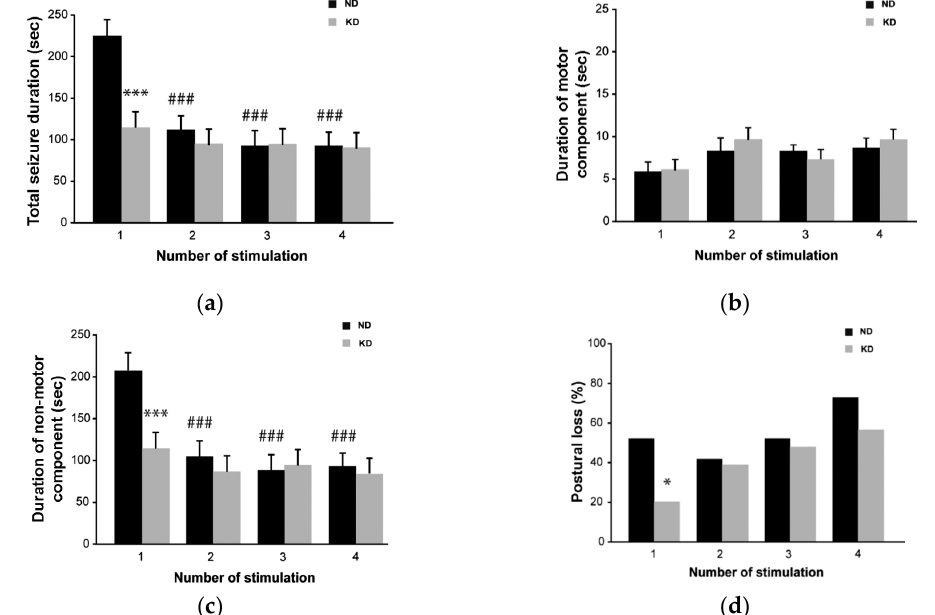
Figure 1. Behavioral changes during repeated 6-Hz corneal stimulation in mice fed the ketogenic diet (KD). ( a ) Seizure duration, considered as the overall period including both motor (convulsions) and non-motor (stunned posture) components of the seizure, was significantly shorter in KD vs. control mice at the first session (*** p < 0.001; Holm–Šídák test); however, after the first session the seizure duration decreased in control mice (### p < 0.001 for sessions 2, 3 and 4 vs. session 1) and no differences were observed between the two groups. ( b ) Histograms illustrating the mean duration of the motor component of the seizure. Note that no differences were found between the two treatment groups. ( c ) Histograms illustrating the mean duration of the non-motor component of the seizure, which was significantly shorter in KD vs. control mice only at the first session of corneal stimulation (*** p < 0.001). Note that this component decreased in control mice from the second to the last session (### p < 0.001 vs. session 1). For this reason, no treatment-related differences were observed in sessions 2–4. ( d ) Note that the KD significantly reduced the number of animals developing generalized tonic-clonic convulsions with postural loss at the first seizure induction (* p < 0.05, Fisher’s exact test). However, this difference was not appreciated in further sessions; n = 9 for the normal diet (ND) group; n = 9 for KD group. Statistical significance values are indicated as *: p < 0.05, ***: p < 0.001, ###: p < 0.001.